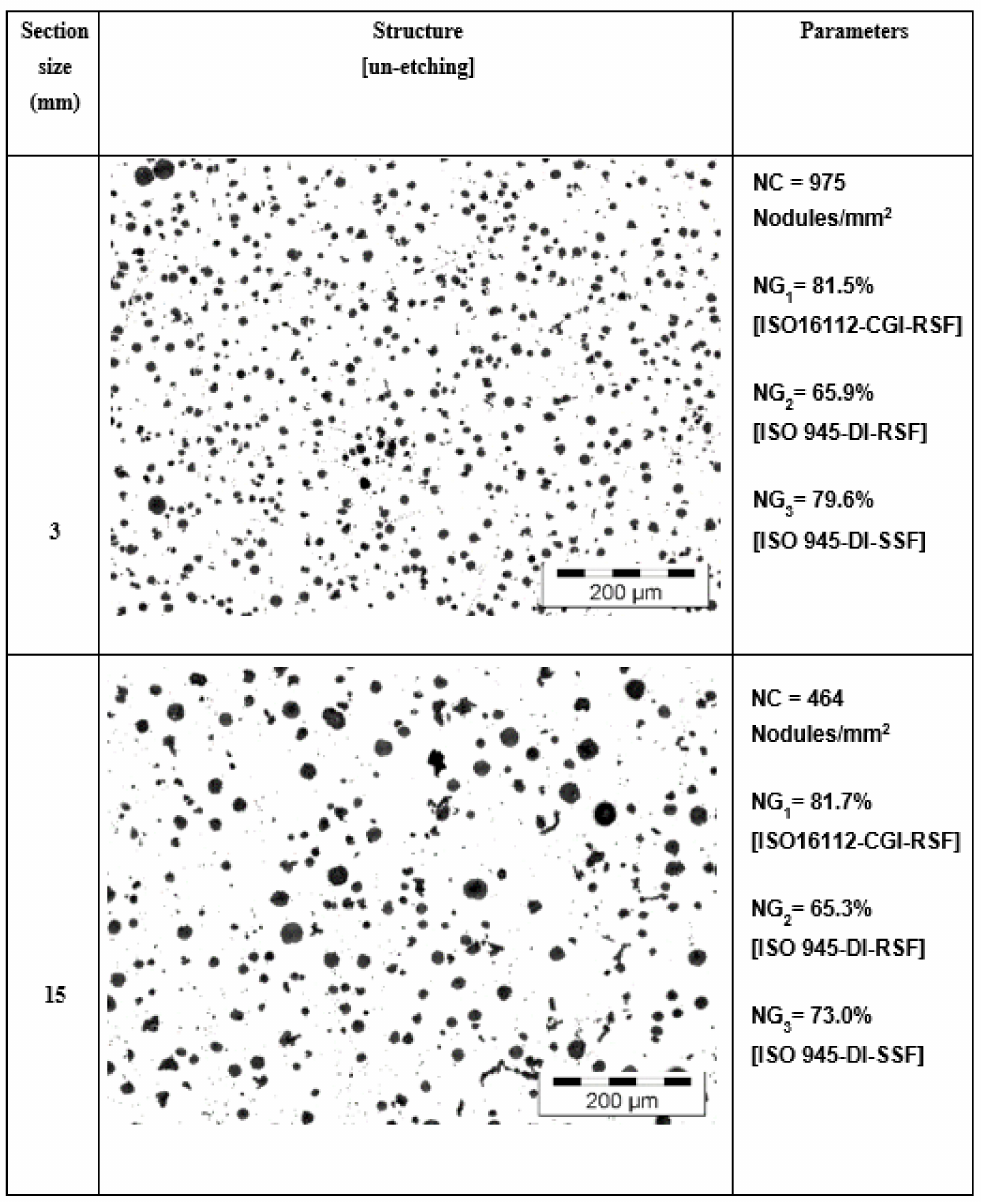
Figure 13. Comparison of the microstructures, the nodule count (NC), and the calculated graphite nodularity [NG 1 , NG 2 , NG 3 ] for the 3 and 15 mm wedge casting wall